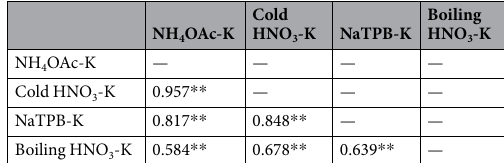
— Table 1. Correlation between soil-test K extracted with 1.0 mol L − 1 NH 4 OAc, 2.0 mol L − 1 cold HNO 3